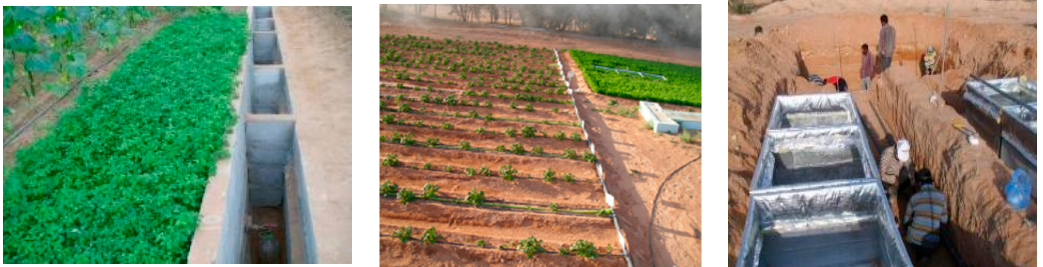
Figure 2. The installation of the lysimeters to determine Crop evapotranspiration (ETc.)